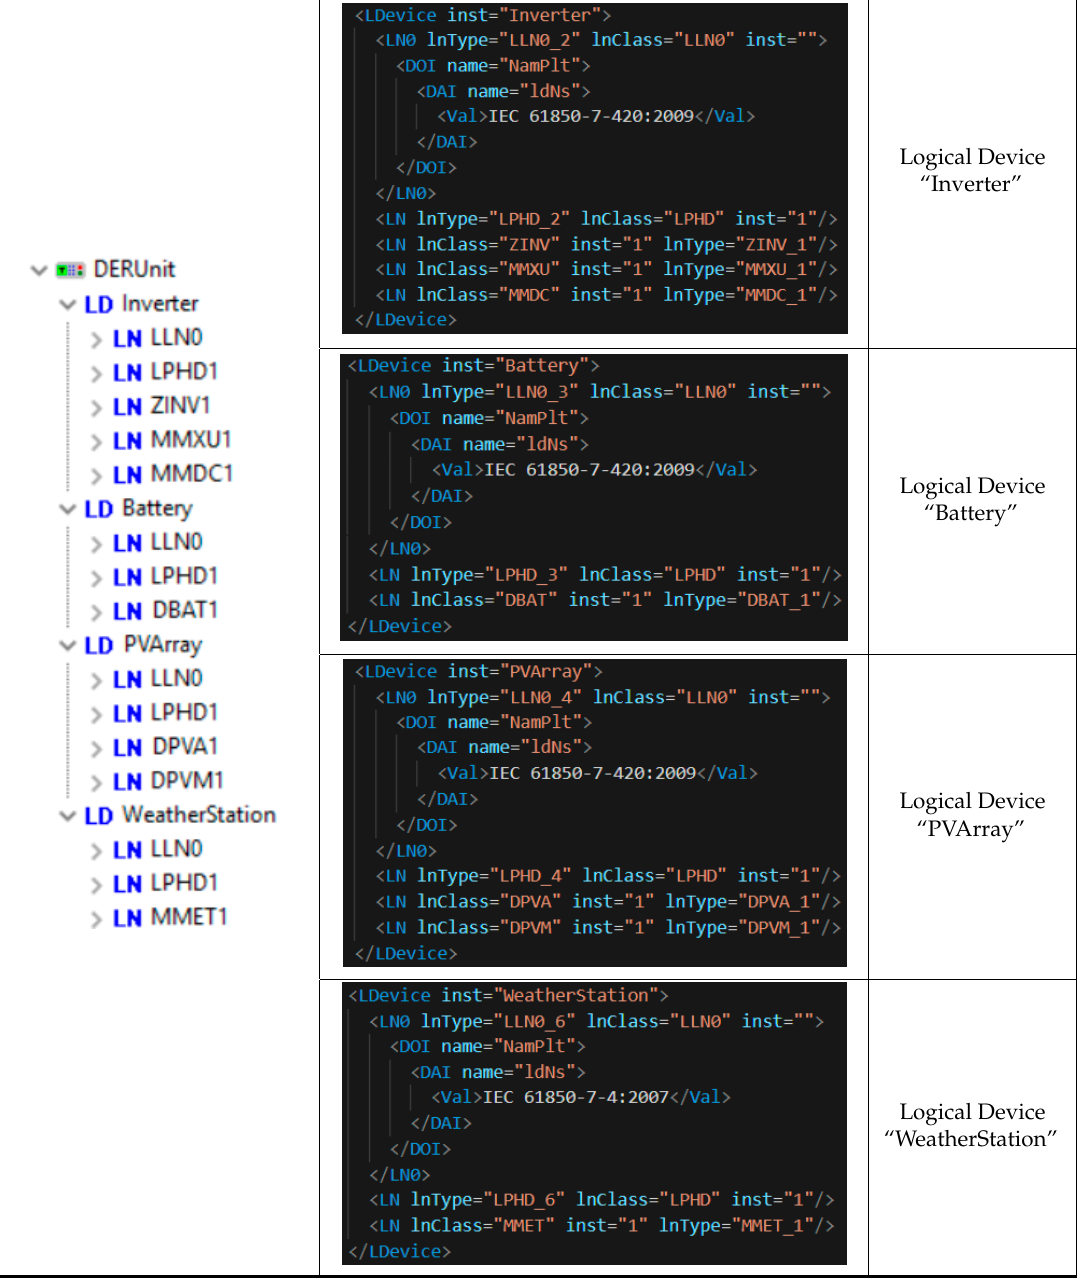
Table 3. Editing IED capability description files (ICD).